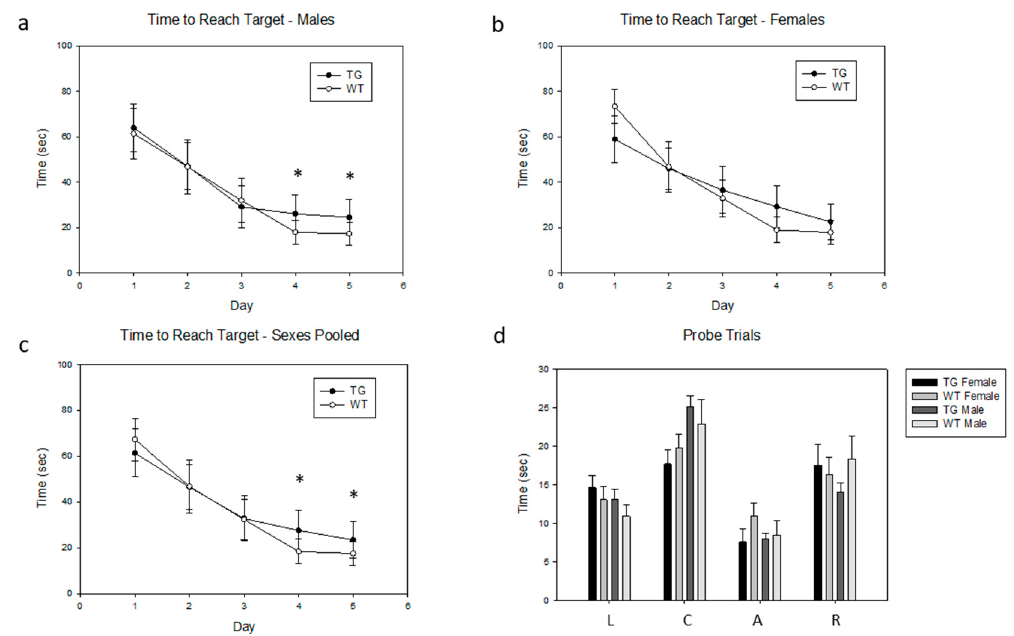
Figure 4. PDE4D5-D556A male mice show increased latency (time to target) in the Morris water maze. Data are means ± SE; asterisks (*) indicate data from the transgenic mice that were statistically different over days 4 and 5 from that obtained from wild-type mice. ( a ) Time to reach target during the training phase, males. ( b ) Time to reach target during the training phase, females. ( c ) Time to reach target during the training phase, sexes pooled. ( d ) Probe trials: time spent in each quadrant for each genotype and sex. L: left quadrant; C: contralateral quadrant; A: quadrant that previously contained the target; R: right quadrant.